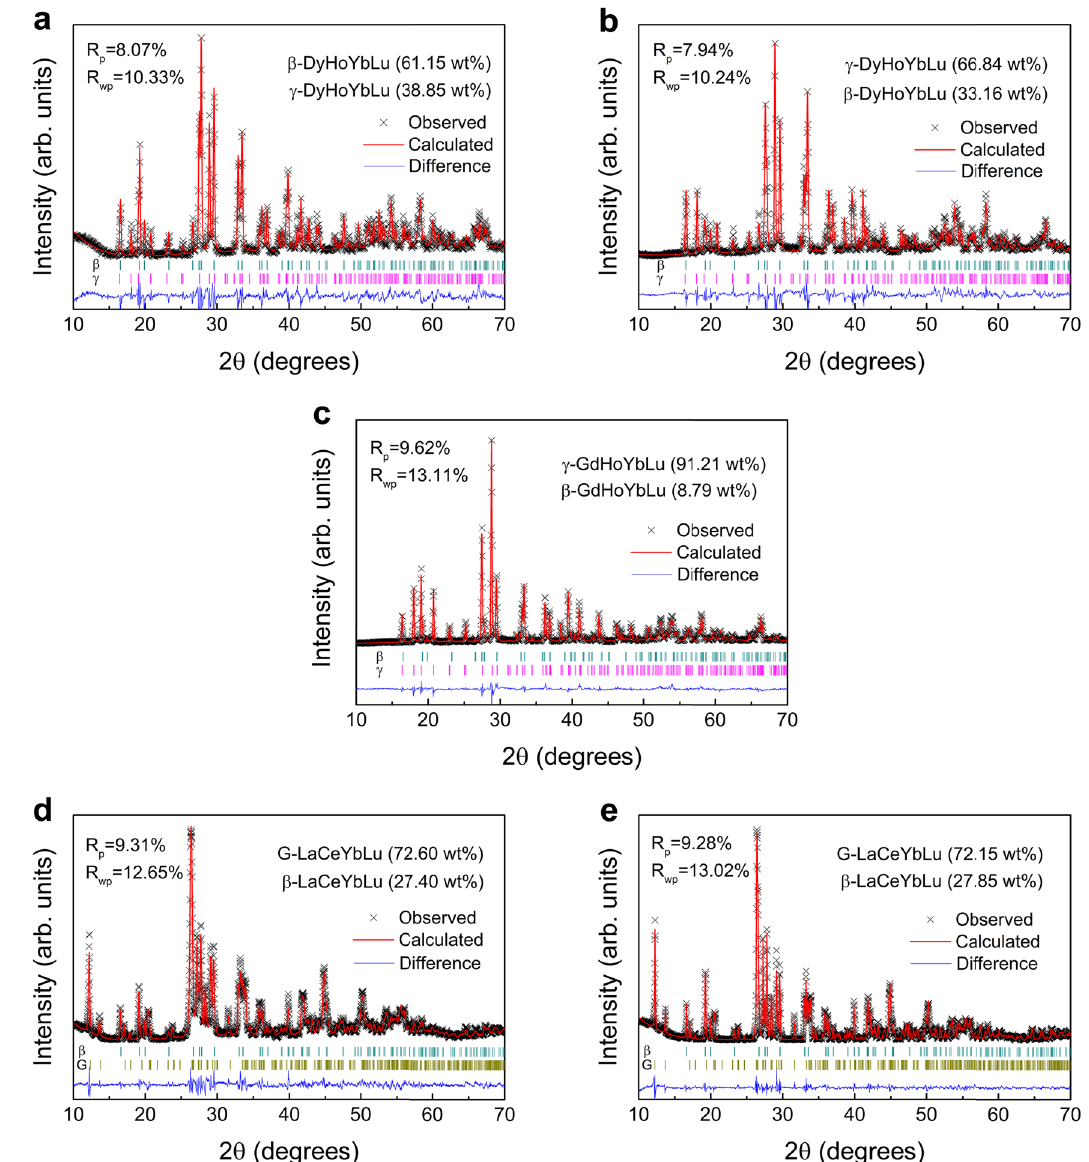
R p and wp arealsopresentedinthe lines in dark cyan, magenta and dark yellow color at the bottom of each panel denote the positions of XRD peaks of β -RE 2 Si 2 O 7 , γ -RE 2 Si 2 O 7 , and G-RE 2 Si 2 O 7 ,